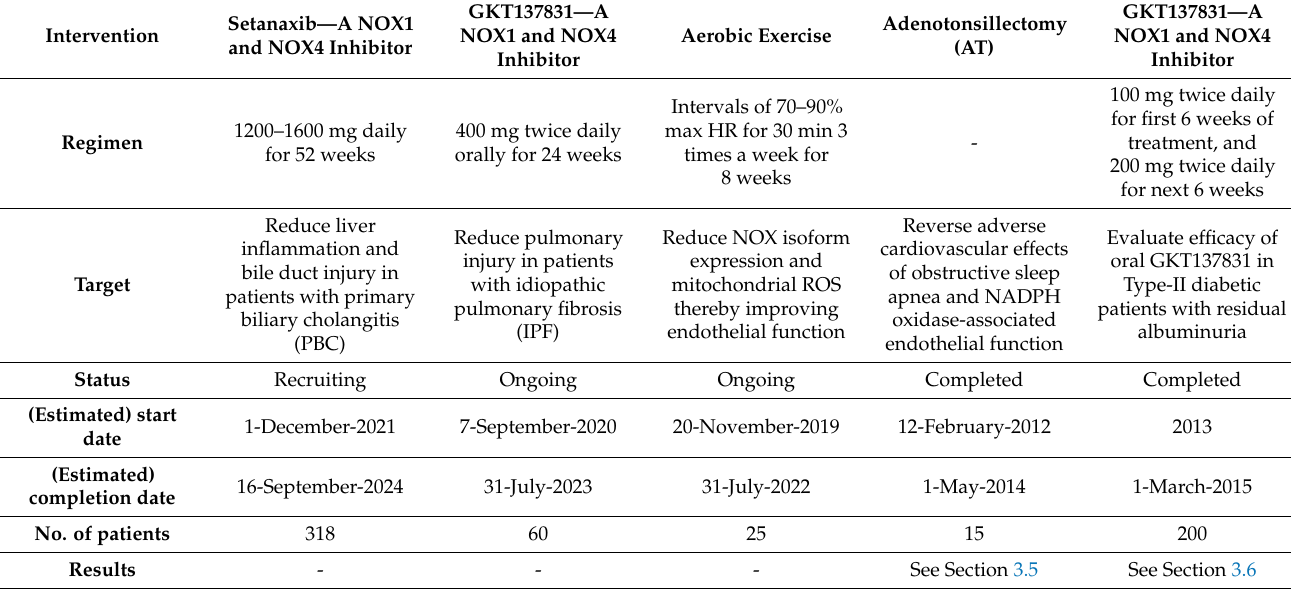
Table 1. Recent clinical trials targeting NADPH oxidases to improve vascular